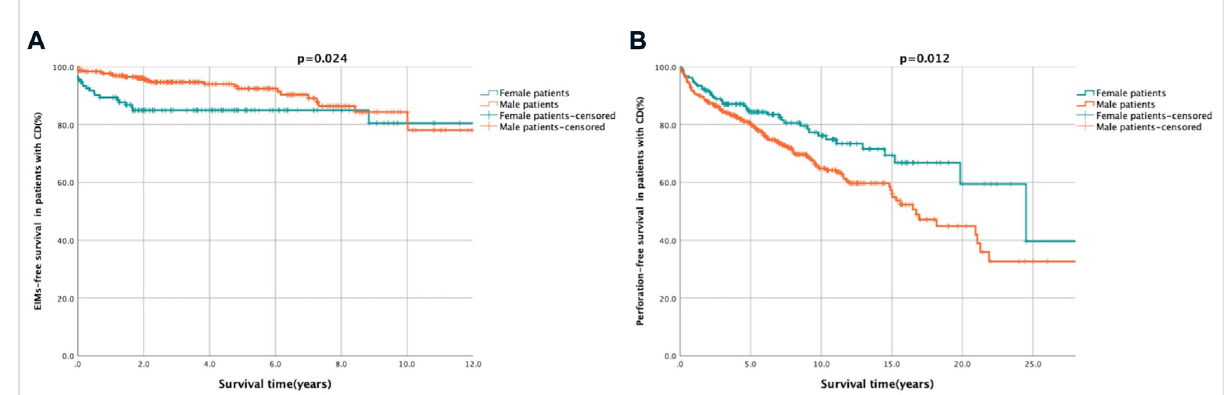
FIGURE 2 Kaplan-Meier survival curve presenting the EIMs- and perforation-free survival of female and male patients. Description: (A) EIMs-free after diagnosis survival of female and male patients. Female patients showed a trend towards shorter EIMs-free survival. (B) Perforation-free after diagnosissurvivaloffemaleandmalepatients.Malepatientsshowedatrendtowardsshorterperforation-freesurvival.EIMs-freesurvivalwasde fi ned as the period from diagnosis to occurrence of EIMs. Perforation-free survival was de fi ned as the period from diagnosis to occurrence of CD related gastrointestinal penetrating